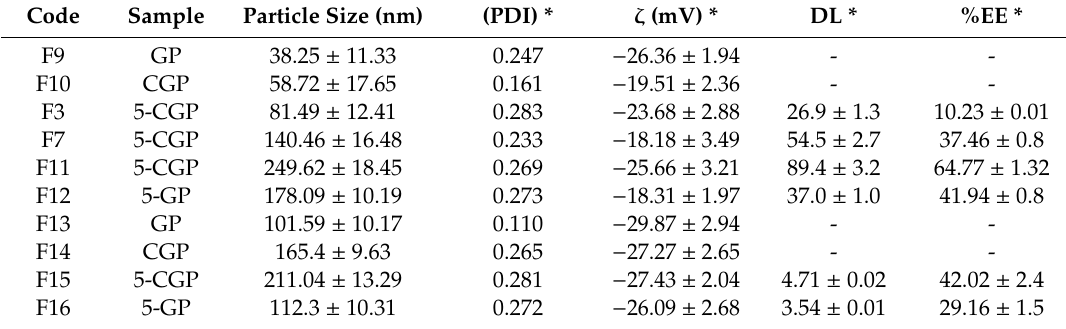
Table 2. Characterizations of the selected stable placebo and 5-FU ferrying gold nanoparticles formulation with or without capped BSA (Bovine serum albumin).